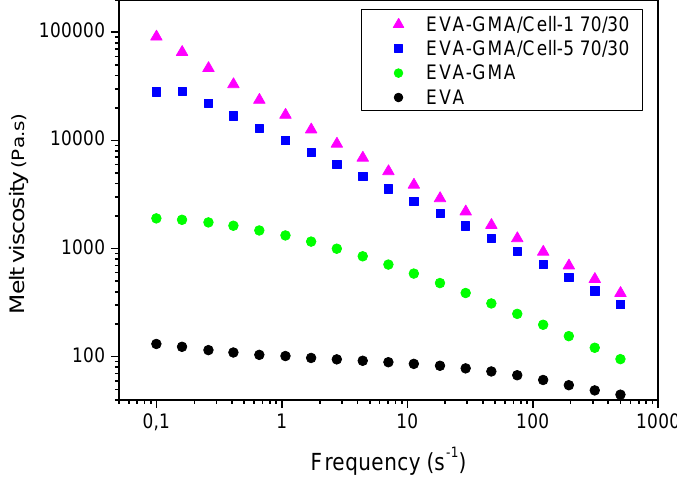
Figure 18. Melt viscosity of EVA-GMA/Cell composites and plain polymers as a function of